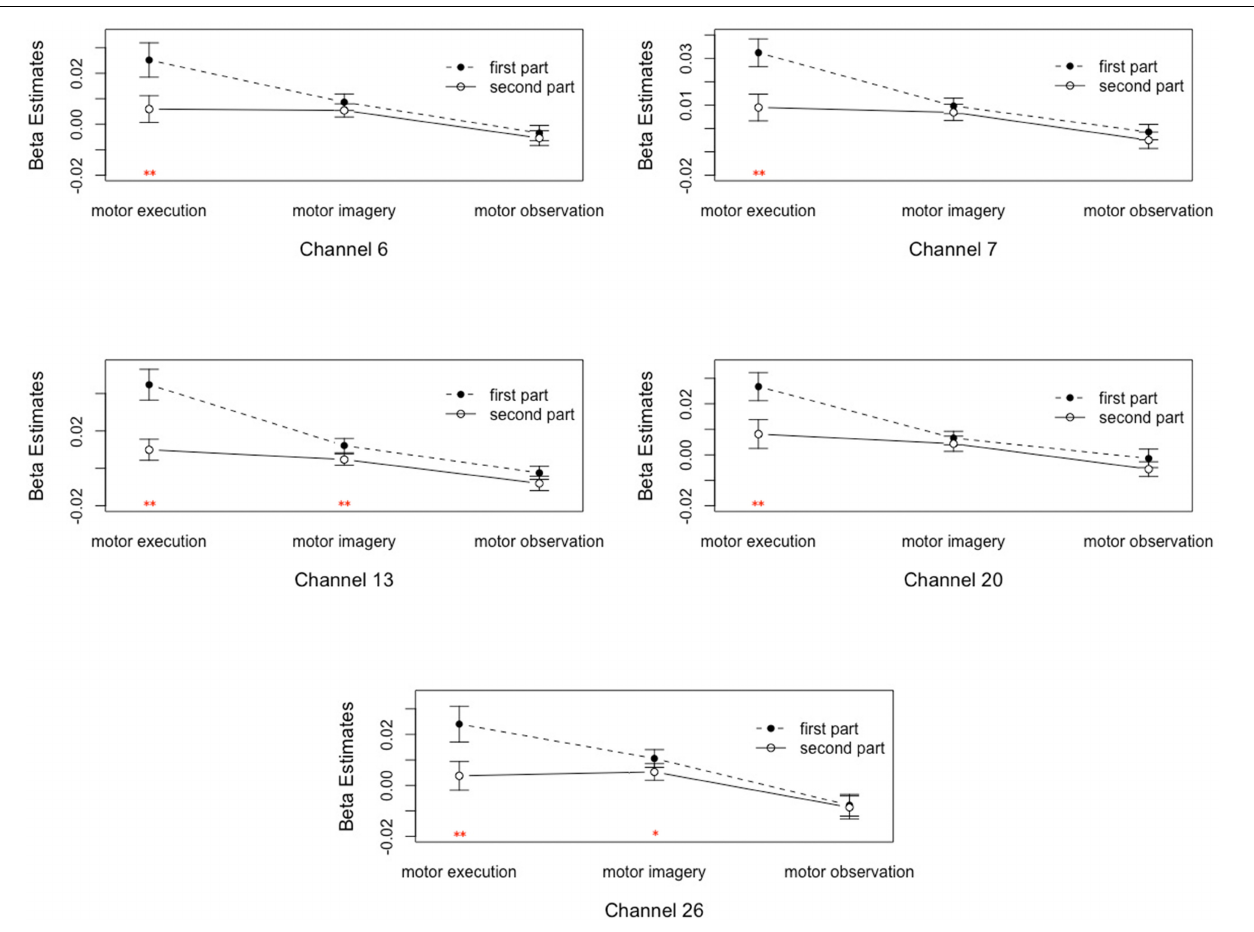
FIGURE 3 | Analysis of the interactions between the motor tasks and time. Error bars represent standard errors. ∗ P < 0.05, ∗∗ P <